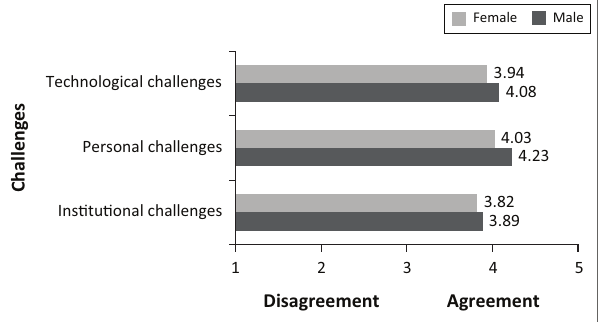
FIGURE 2: Challenges differences across demographics